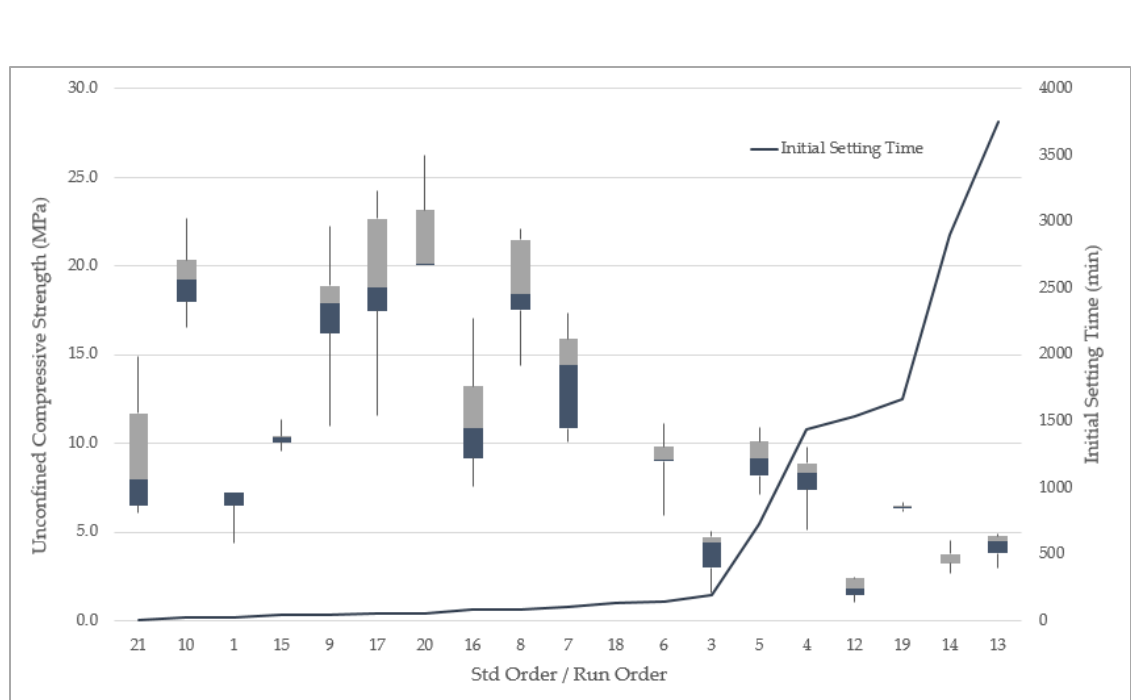
Figure 2. Unconfined compressive strength (boxplot) and initial setting time (line graph) per run.